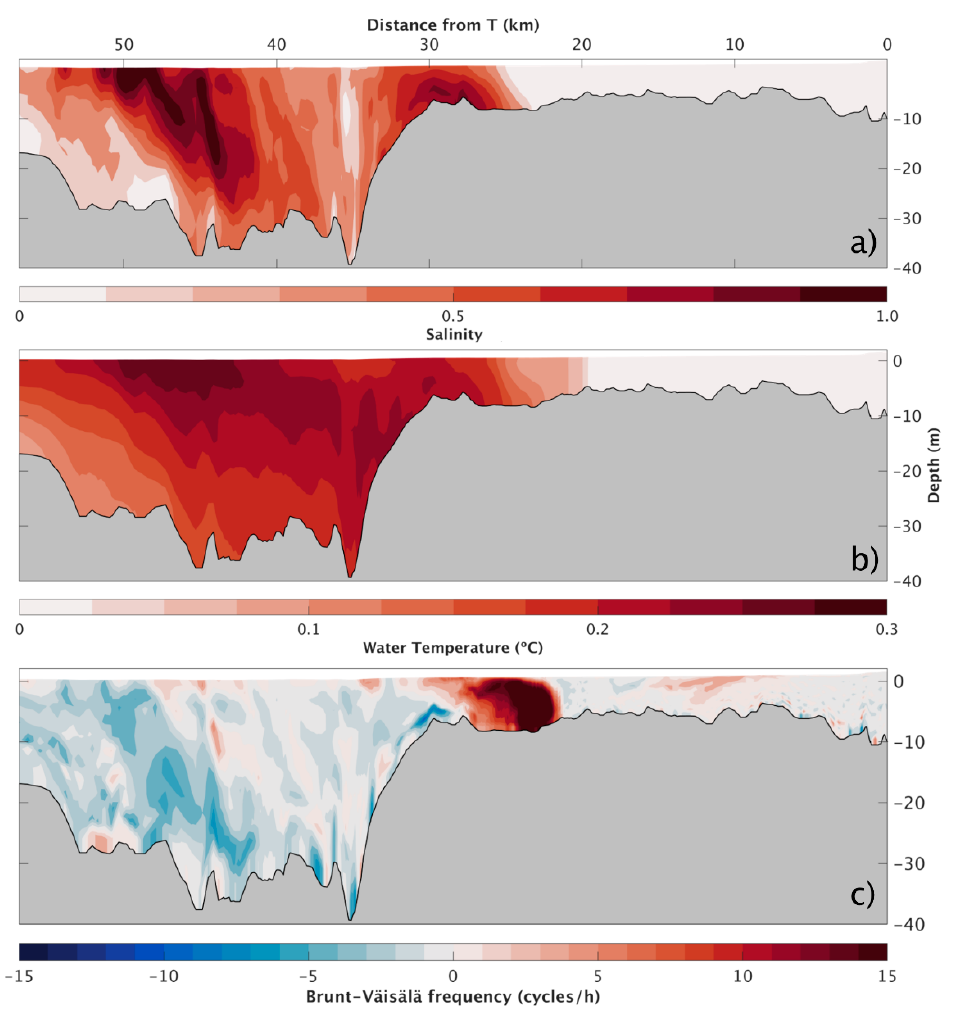
Figure 9. Difference between #Sc3 and #ScRef, in terms of ( a ) salinity; ( b ) water temperature; ( c ) Brunt–Väisälä frequency.